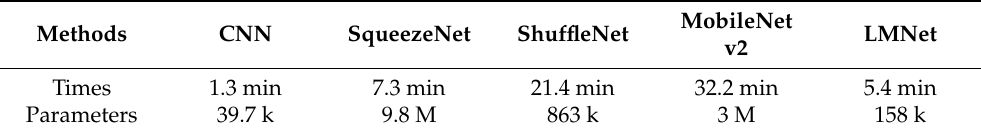
Table 4. The training times and parameters of compared methods.